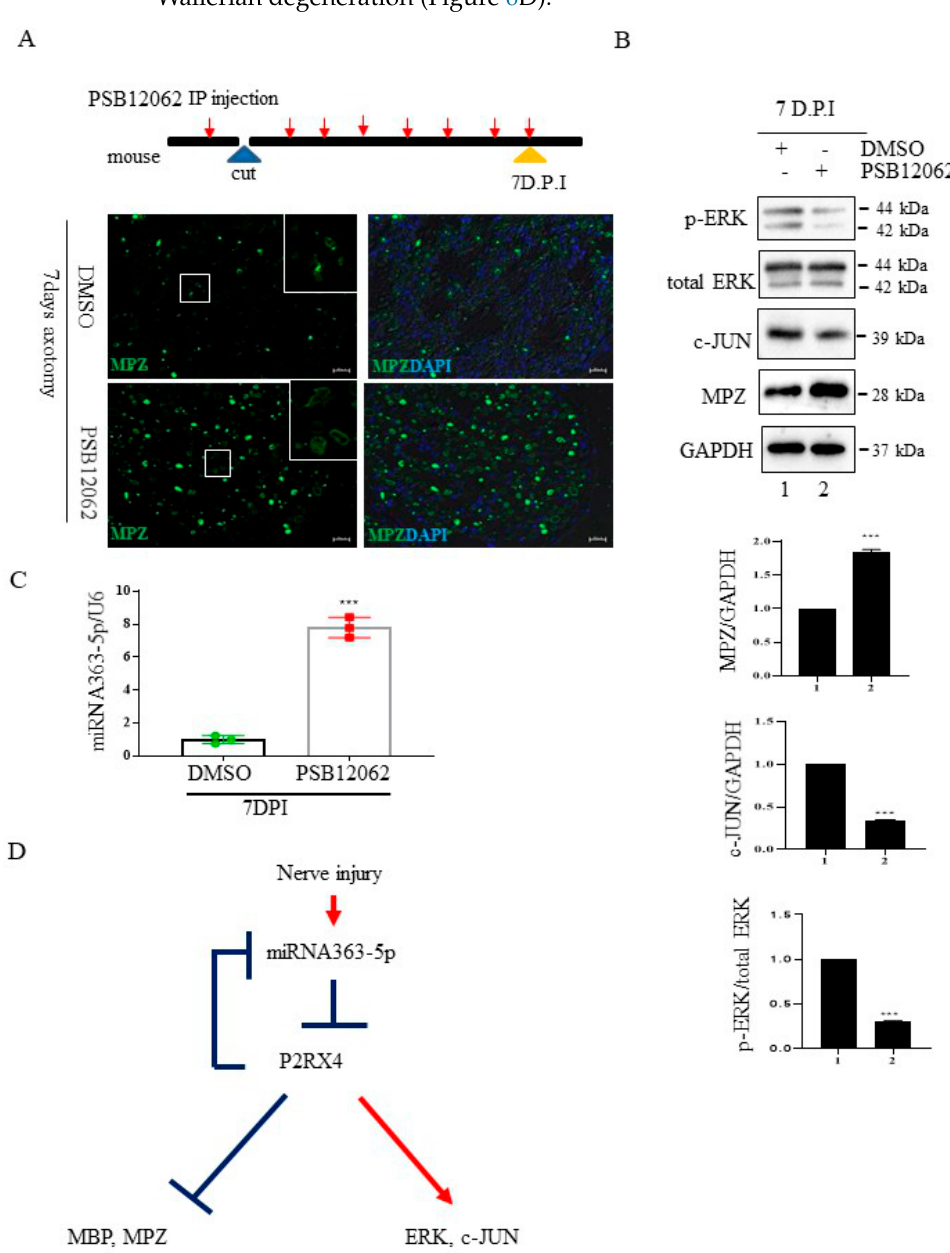
Figure 6. The P2RX4 antagonist PSB12062 blocked the degradation of myelination after nerve injury or during postnatal development in vivo. ( A ) Top, a schematic of P2RX4 antagonist administration after nerve axotomy. A P2RX4 antagonist (PSB12062) was intraperitoneally injected, once per day, from the day before nerve axotomy until 7 days postaxotomy. Bottom, immunofluorescence staining for MPZ (green) in sciatic nerves at 7 DPI compared with the control. Scale bar = 20 μ m. ( B ) Western blot analysis of pERK and MPZ from the sciatic nerve of mice treated with PSB12062 and control (DMSO)